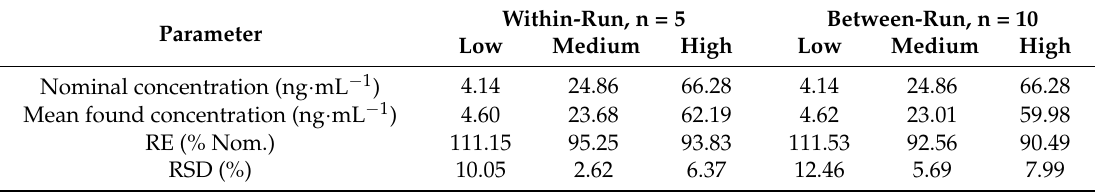
Table 2. Accuracy and precision data from QC samples (low, medium, high).